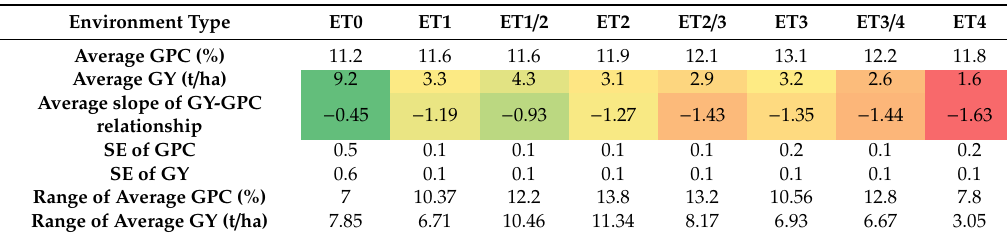
Table 2. Average grain yield (GY), grain protein content (GPC), and the slope of the GY–GPC relationship in individual environment types (ETs). Slope, average GY and average GPC were obtained from individual sites in each year and have been averaged. SE: standard